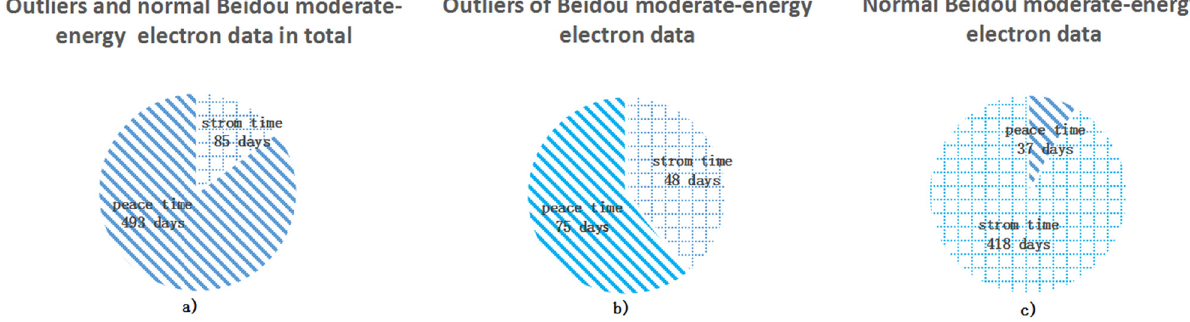
Figure 10: Basic properties of the dataset. ( a ) BeiDou moderate - energy electron data in total. ( b ) Outliers of BeiDou moderate - energy electron data. ( c ) Normal BeiDou moderate - energy electron data.